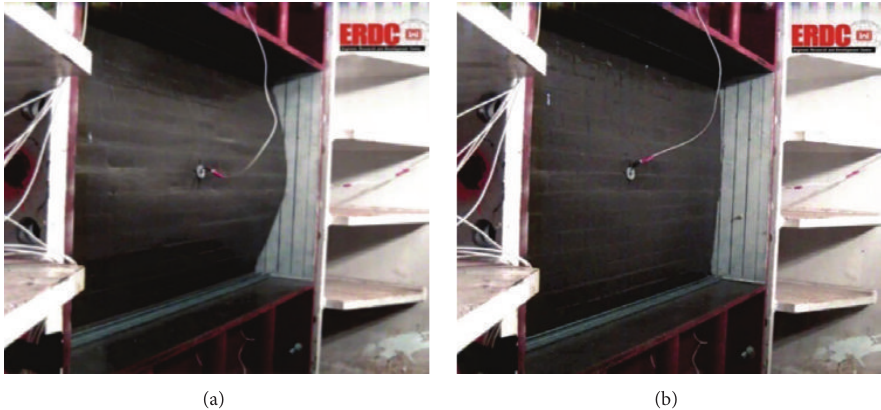
Figure 4: POSS-reinforced wall (a) at maximum deflection and (b) in the final stage [10,